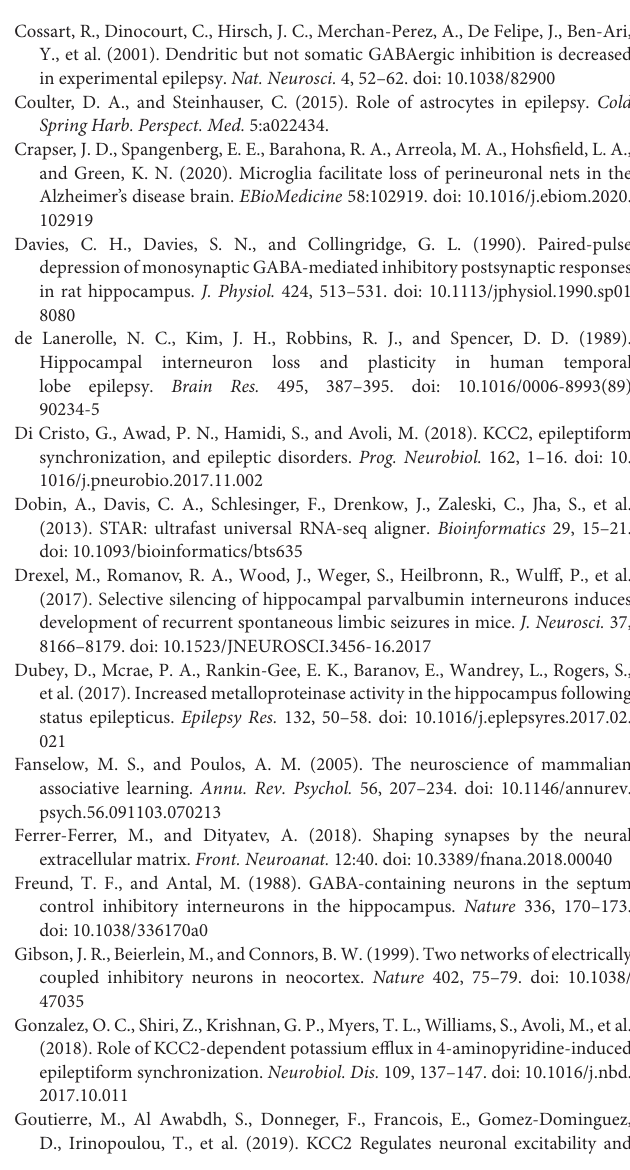
Supplementary Figure 4 | Altered neurites in 23-week-old KCC2 KO PV mice. TdTomato-signals from S1 (left), the retrospenial (RSP) cortex (middle), and the hippocampus of WT PV (upper) and KCC2 KO PV (lower) brain sections. Scale bars 100 µ m. Supplementary Table 1 | Individual numbers for the quantification of tdTomato-positive cells displayed in Figures 5D–G